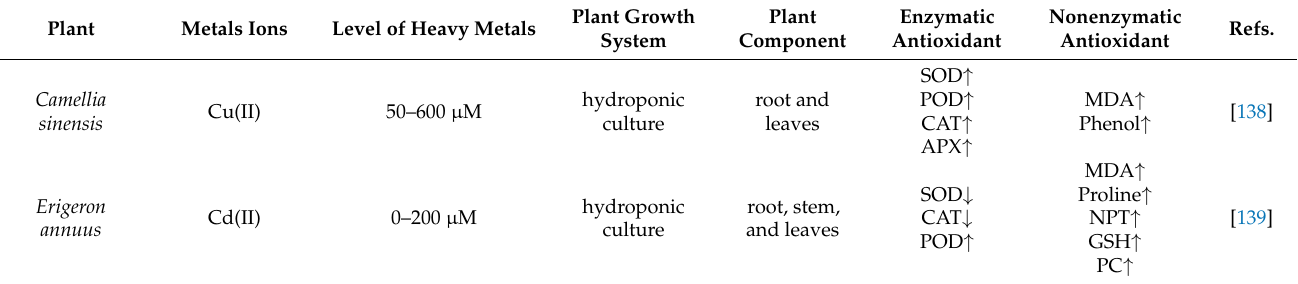
Table 2. Heavy metals effects on enzymatic and non-enzymatic antioxidants in medicinal plants.